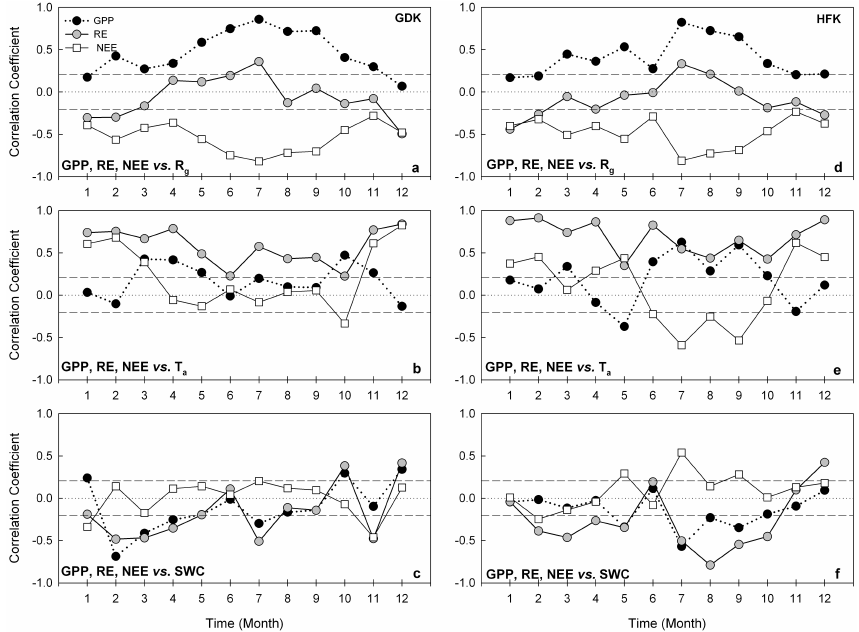
Fig. 6. Correlation of anomalies in environmental conditions (solar radiation, R g , air temperature, T a , and Soil Water Content, SWC) and carbon budget components. The long dashed lines represent critical values of correlation coefficients at the 95% confidence interval with n =90 for each